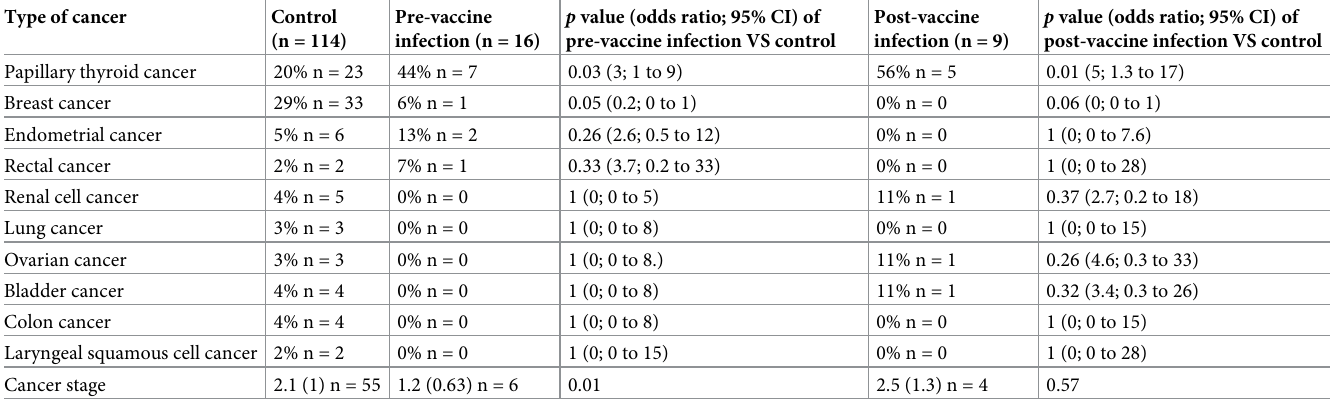
Table 2. Cancer characteristics.